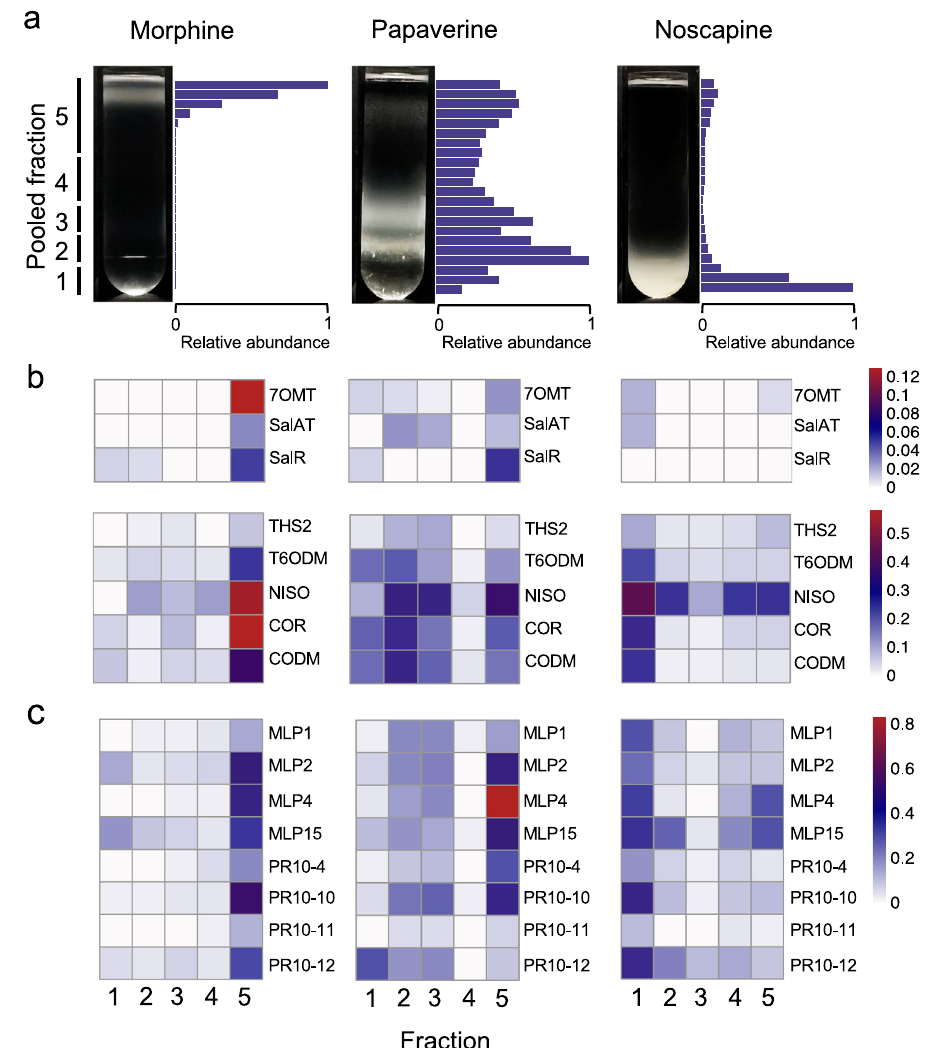
Fig. 2 | Sucrose-gradient analysis of alkaloid-added Przemko latex. a Images of sucrosedensitygradientsrunwithPrzemkolatexcontainingexogenousmorphine, papaverine or noscapine, and the relative abundance of the exogenous alkaloid in gradient fractions (blue bars). The pooled fractions used for shotgun proteomics are indicated on the left side. Alkaloid levels were normalized to the fraction with the greatest abundance. b Heat maps showing the relative abundance of BIA bio- synthetic enzymes in proteomes of pooled fractions. c Heat maps showing the